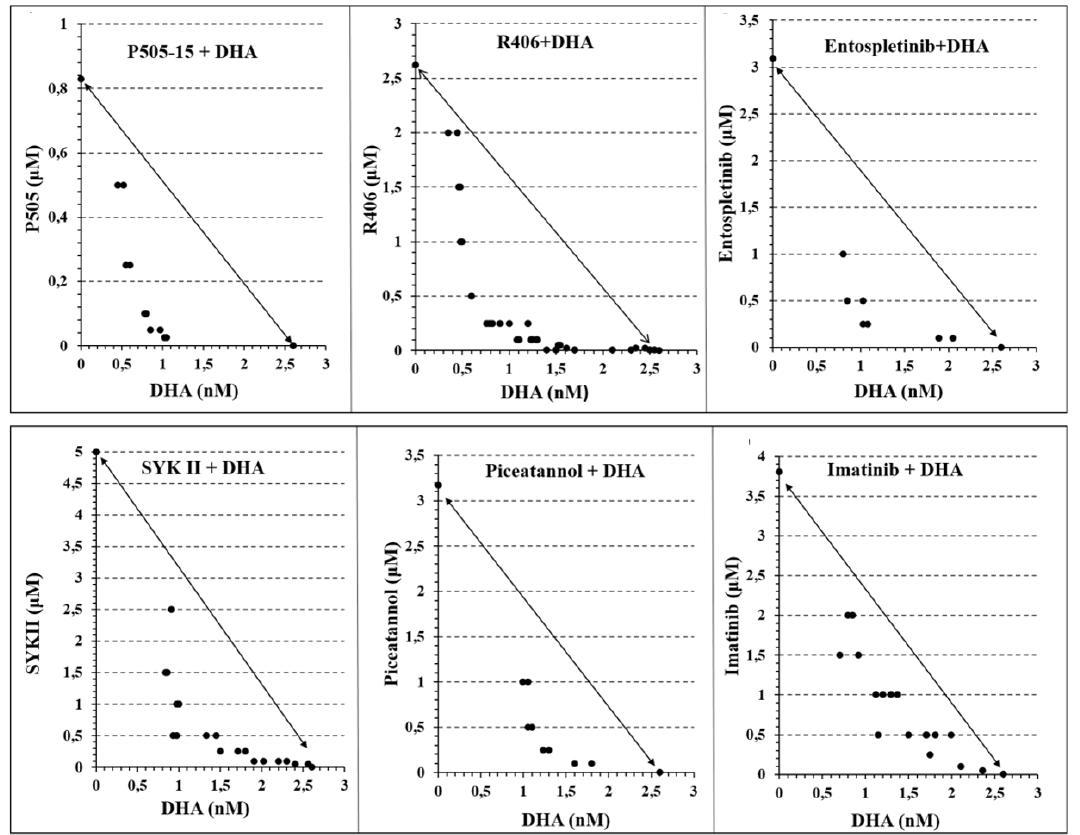
Figure 6. Isobolograms showing the interactions between Syk Inhibitors (P505-15, R406, entospletinib, SYK II, piceatannol, and imatinib) and dihydroartemisinin (DHA), after 24 h of incubation in the P . falciparum Palo Alto strain. Synchronized P. falciparum cultures were treated for 24 h with different concentrations (from 0.05 to 2.5 µM) of different Syk inhibitors (P505-15, R406, entospletinib, SYK II, piceatannol, and imatinib) in combination with different concentrations of DHA (from 0.6 to 10 nM) at the ring stage. IC 50 concentrations of all the drug combinations were plotted in isobolograms to determine synergy, additivity, or antagonism.